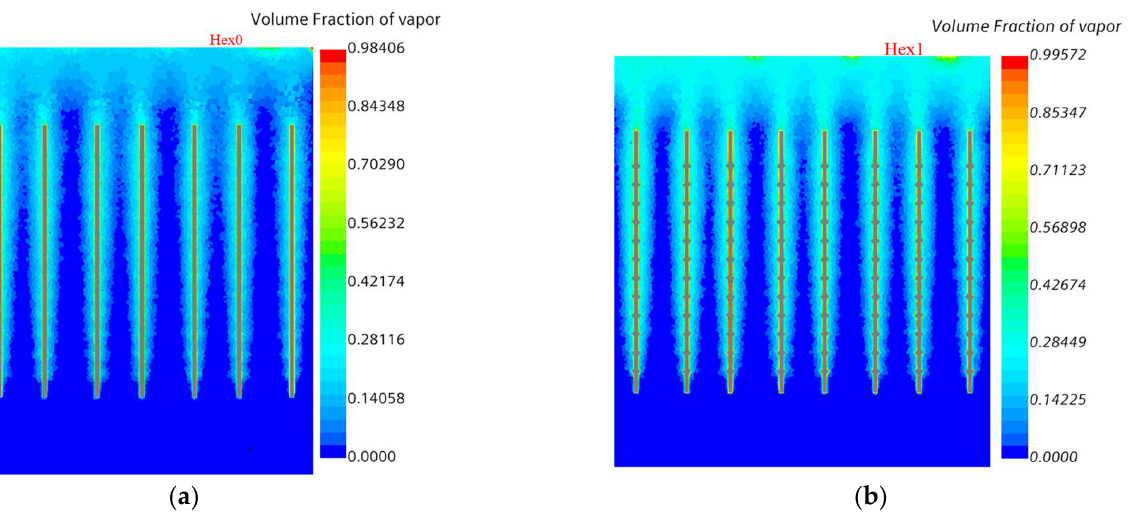
Figure 9. Volume fraction contours of Hex0 and Hex1. ( a ) Volume fraction of Hex0 ( b ) Volume fraction of Hex1.